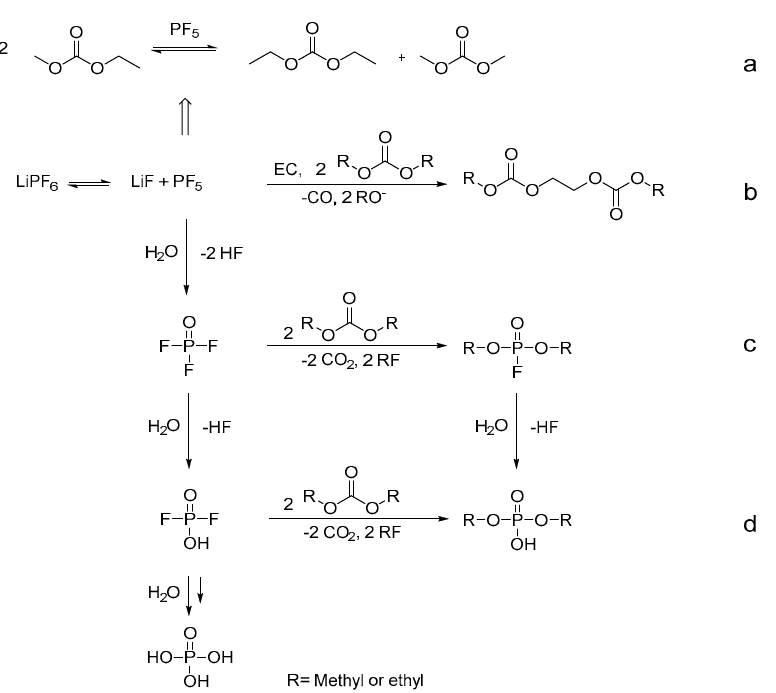
Figure 2. General decomposition pathways for the formation of: transesterifications products ( a ); oligocarbonate-based products ( b ); organophosphate-based products ( c ); organic fluorophosphate-based products; and hydrolysis products ( d ) [43,84–91].